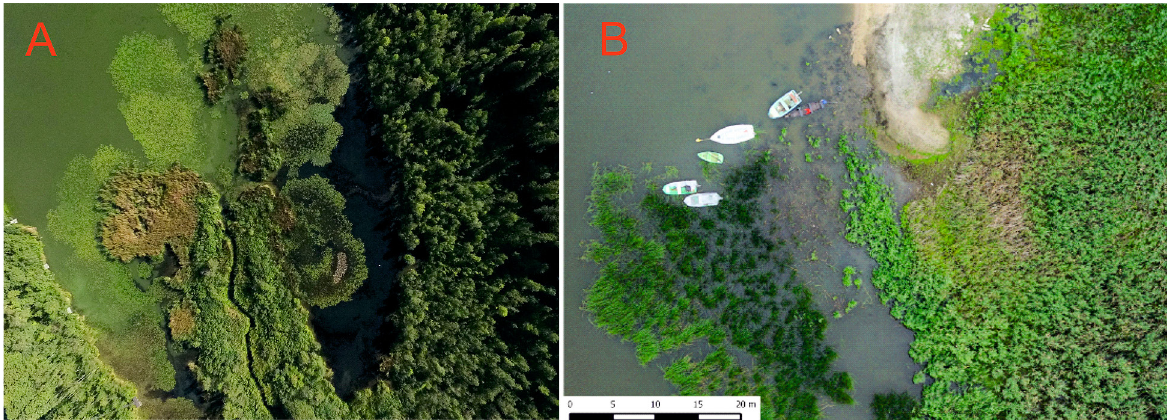
Fig. 7. Influence of the Dojca River to Lake Wolsztyńskie (A) and the accessibility of the shores of the Lake Zbąszyńskie